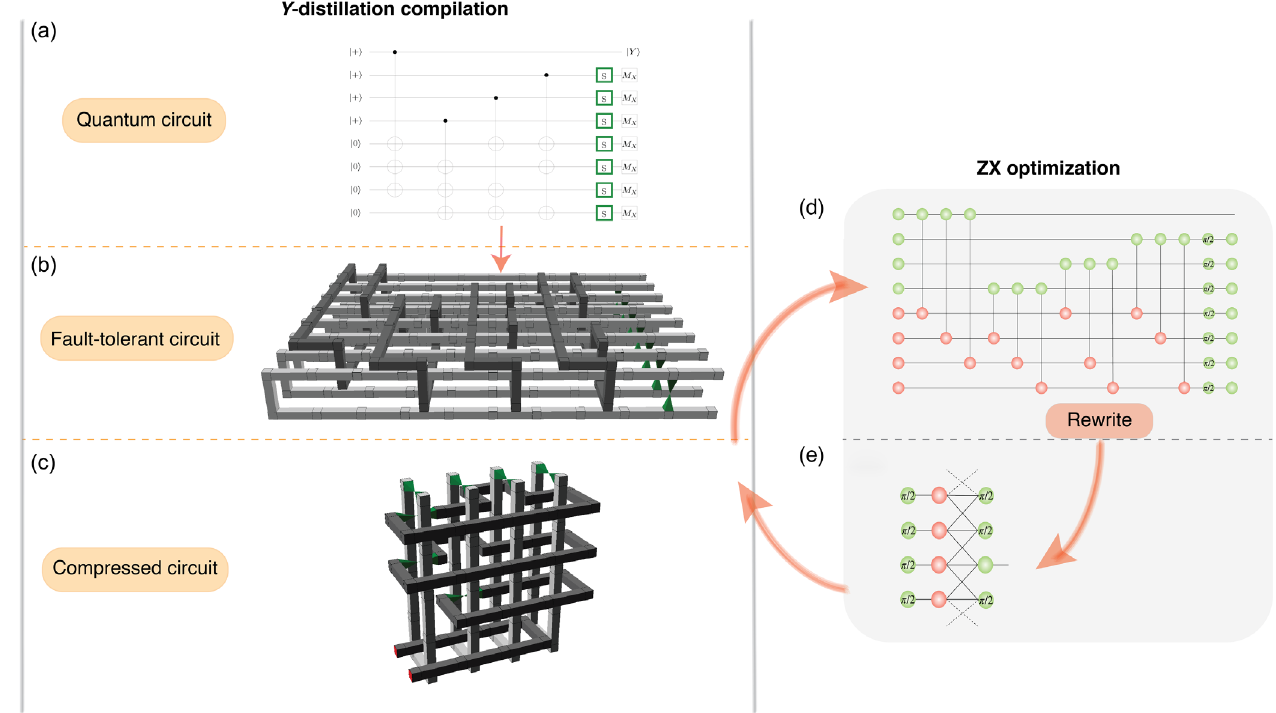
FIG. 6. Compilation and optimization of the Y -distillation circuit. (a) Initial circuit in the diagram form. (b) Initial circuit in the braided representation. (c) Reduced circuit in the braided representation after applying our compression method. (d) Initial circuit in the ZX- calculus representation. (e) Reduced circuit in the ZX-graph representation. Note that the dashed lines indicate periodic